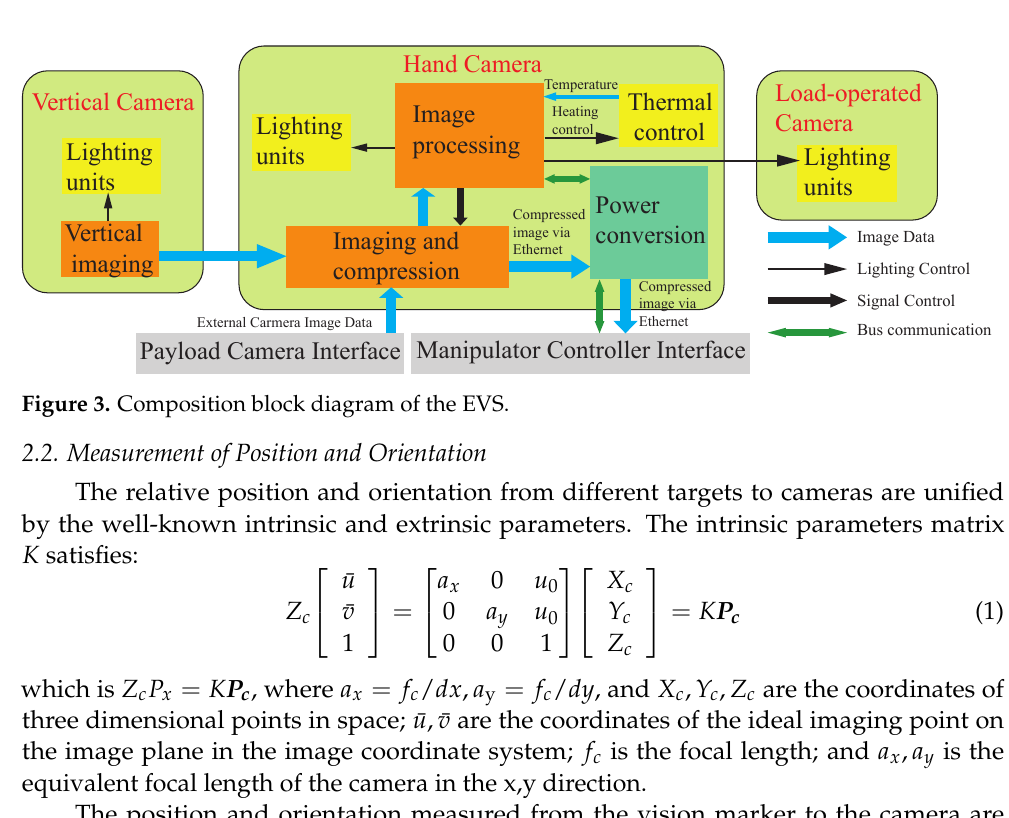
Figure 2. The vision system of the EMM.